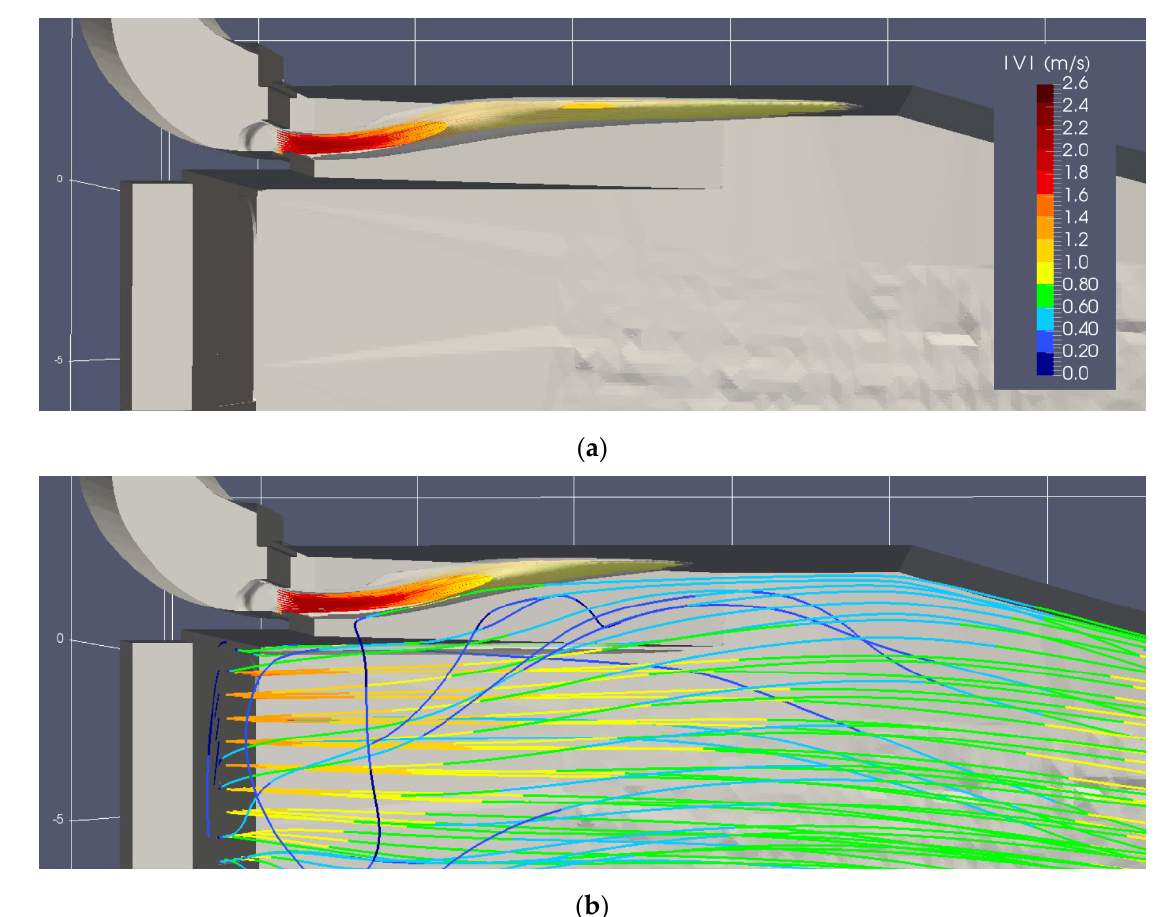
Figure A1. Top view of tailrace and entrance bay of the hydrodynamic-numerical model of the dam in Eddersheim (Main River); streamlines of the attraction flow ( v > 0.8 m/s) and the mean flow field of the turbine are plotted for ( a ) turbine discharge = 0 m 3 /s, ( b ) turbine discharge = 70 m 3 /s.